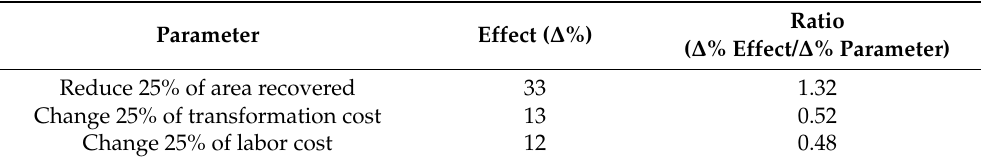
Table 7. Sensitivity analysis results of the principal parameters affecting the r-UF membrane produc- tion